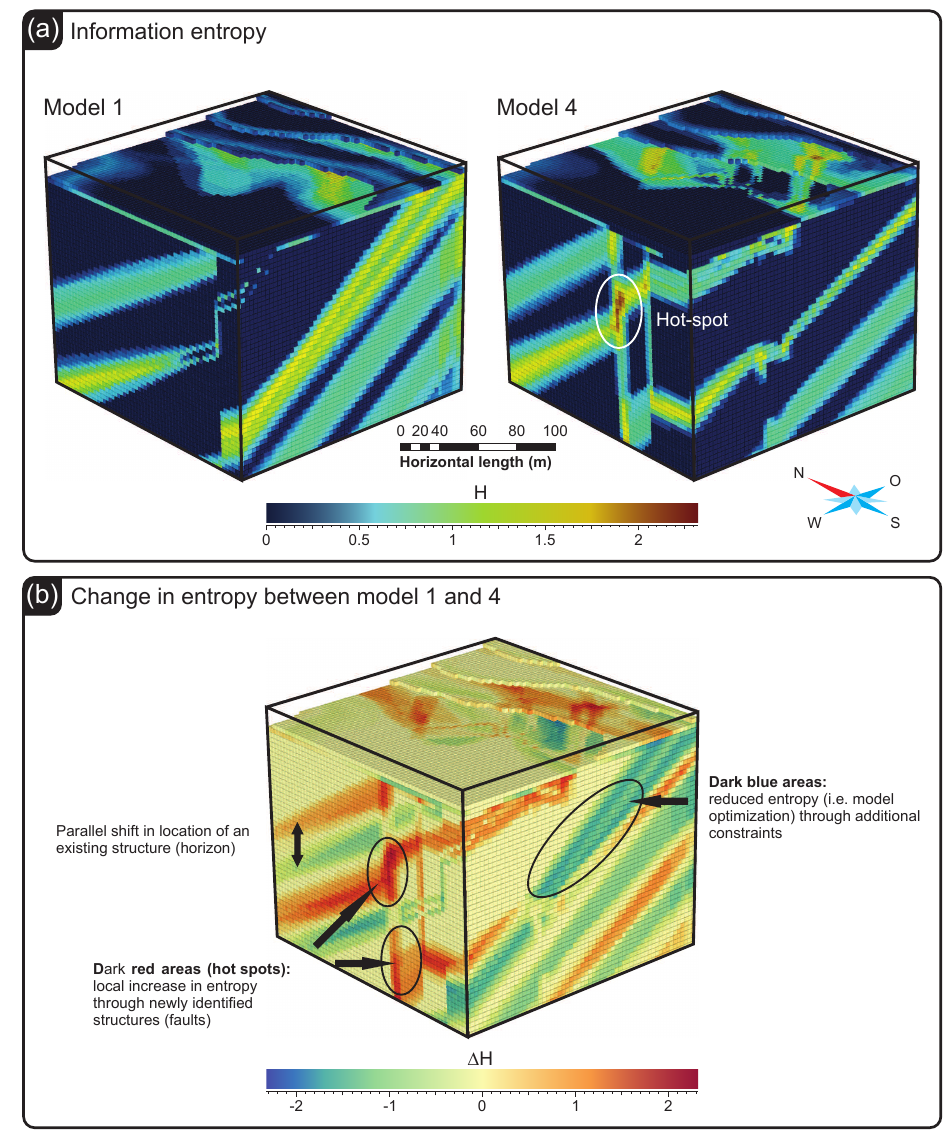
Figure 8. 3-D view of the AOI with a discretization of 5m for (a) average information entropy H M of Models 1 and 4 and (b) change in entropy (cid:49)H x between both